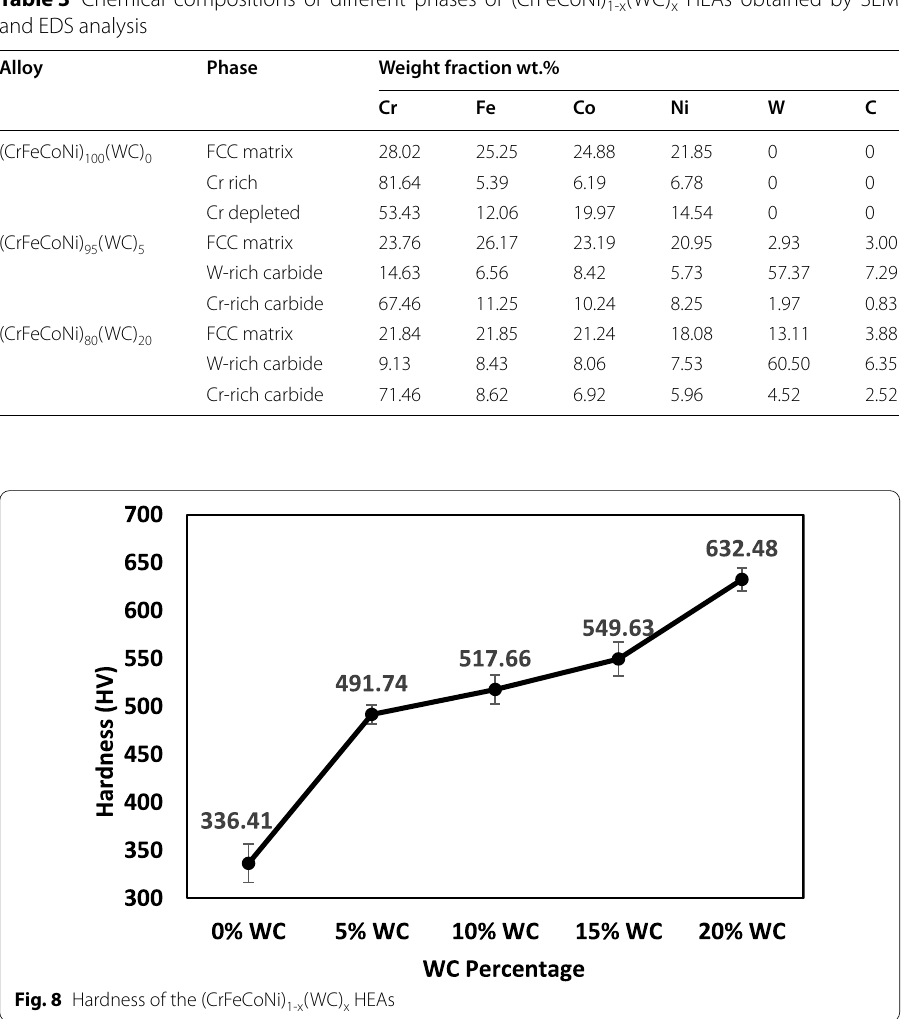
(WC) HEAs obtained by SEM 1-x x